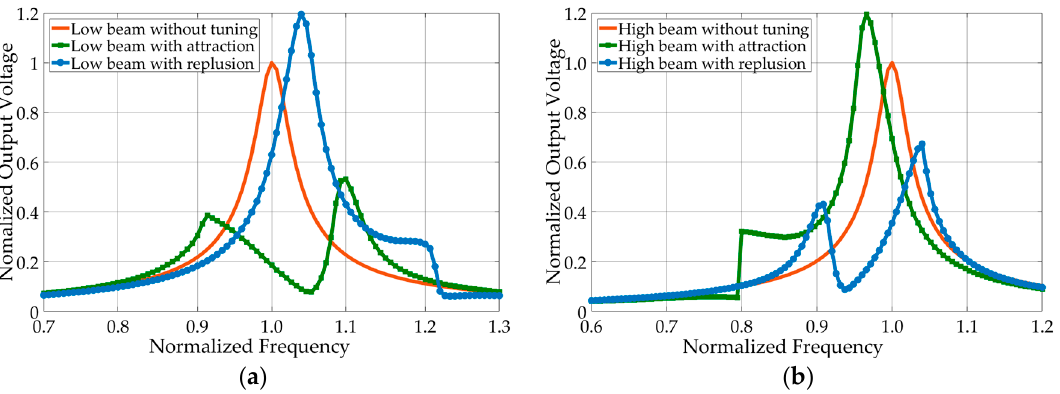
Figure 3. Output voltage simulation curve in different modes: ( a ) Low beam; ( b ) High beam.